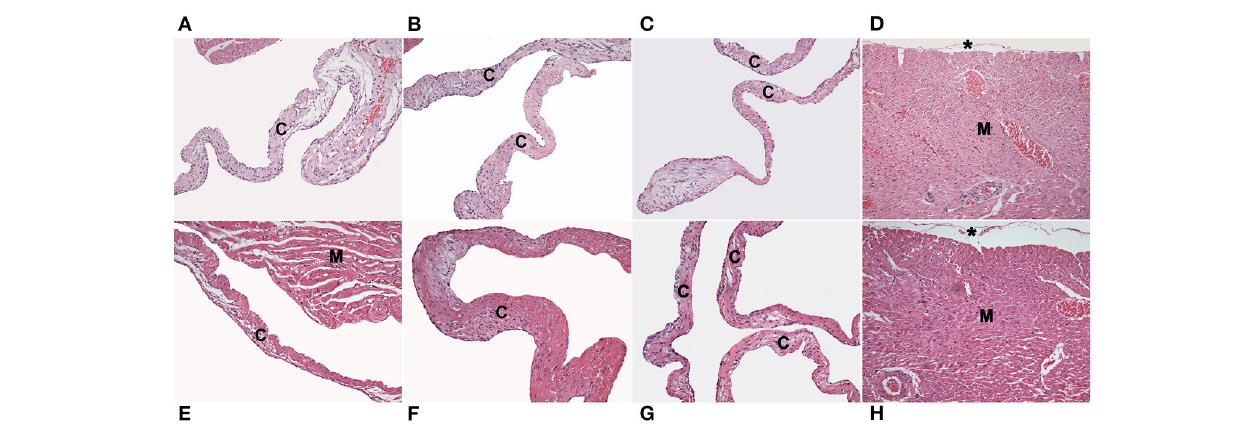
FIGURE 3 | Photomicrographs of histological sections of the tricuspid (A) , mitral (B) and aortic (C) valves, and myocardium (D) from Wistar rats injected with placebo. The tricuspid (E) , mitral (F) and aortic (G) valves, and myocardium (H) from rats injected with a high dose of StreptInCor (200 µ g/ml). There is no necrosis, inflammatory infiltrate, neovascularization, or fibrosis in the valve cusps (c), myocardium (M), or epicardium (*). Hematoxylin and eosin staining, × 200.